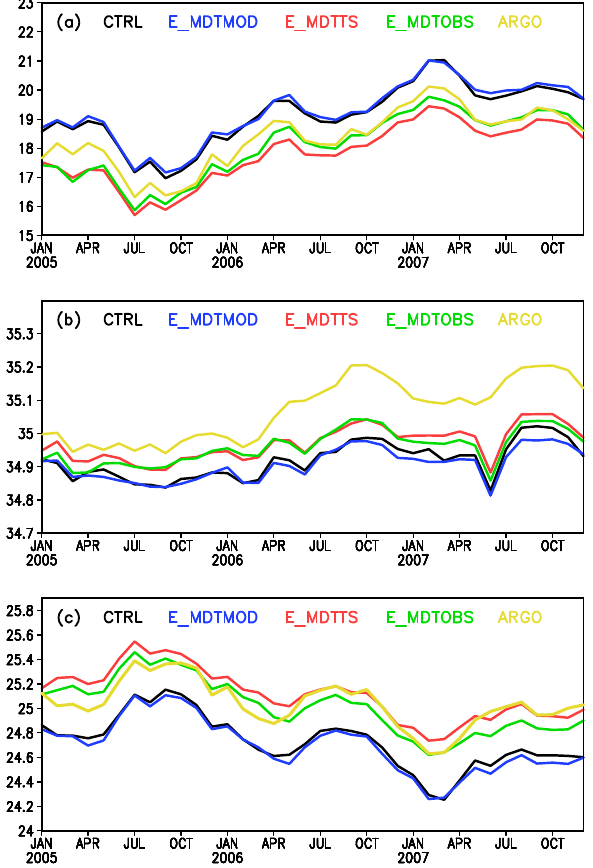
Figure 4. Time series of the RMSEs of temperature ( a ; unit: ◦ C) salinity ( b ; unit: psu) and density ( c ; unit: kgm − 3 ) averaged over the upper 300m in the Pacific–Indian oceans from different exper- iments. Black: CTRL; blue: E_MDTMOD; red: E_MDTTS; green: